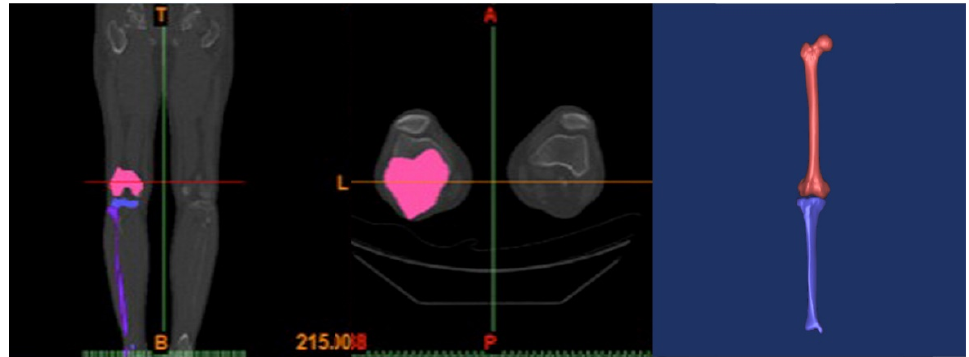
Figure 1. A three-dimensional surface reconstruction of the femur and tibia of a 34-year-old male subject, using Mimics (Materialise Inc., Leuven, Belgium).